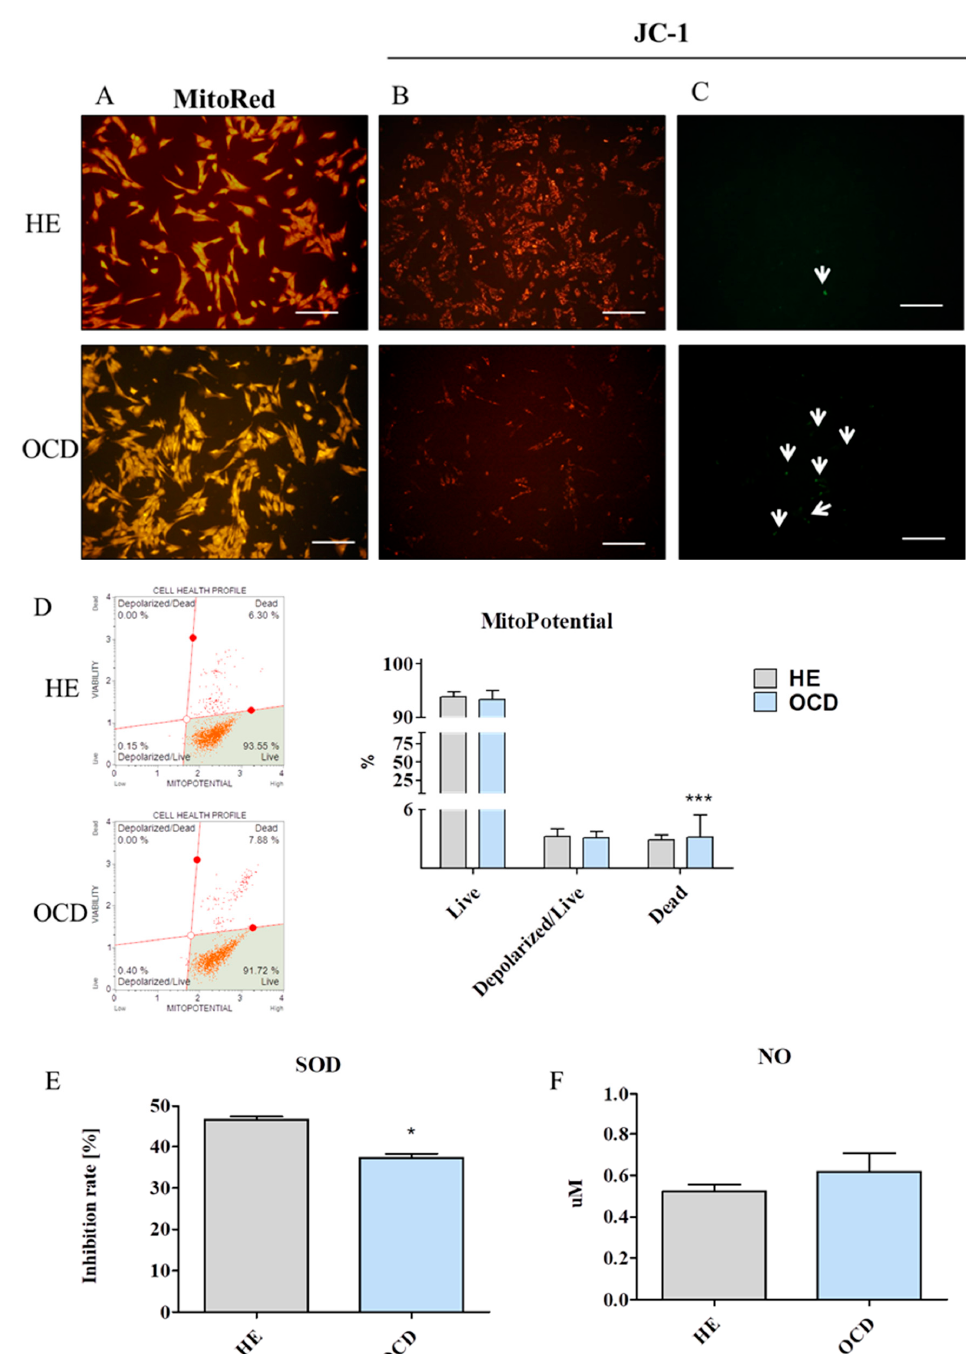
Figure 5. Evaluation of mitochondria condition in equine HE and OCD chondrocytes. Mitochondria of chondrocytes were stained using MitoRed dye and observed under epifluorescent microscope ( A ). Furthermore, to investigate mitochondria condition, cells were stained with JC-1. Mitochondrial depolarization is indicated by a decrease in the red and increase in the green fluorescence. Polarized mitochondria are marked by orange-red fluorescence ( B ) while depolarization is indicated with green fluorescence ( C ). Quantitative data regarding the mitochondria condition was obtained using MitoPotential assay and MUSE Cell Analyzer ( D ). In order to evaluate antioxidative status of chondrocytes activity of superoxide dismutase (SOD) was established ( E ). Furthermore, amount of NO in culture media was evaluated (F). Scale bars: epifluorescent − 250 µ m. Results expressed as mean ± S.D. * p < 0.05, *** p <